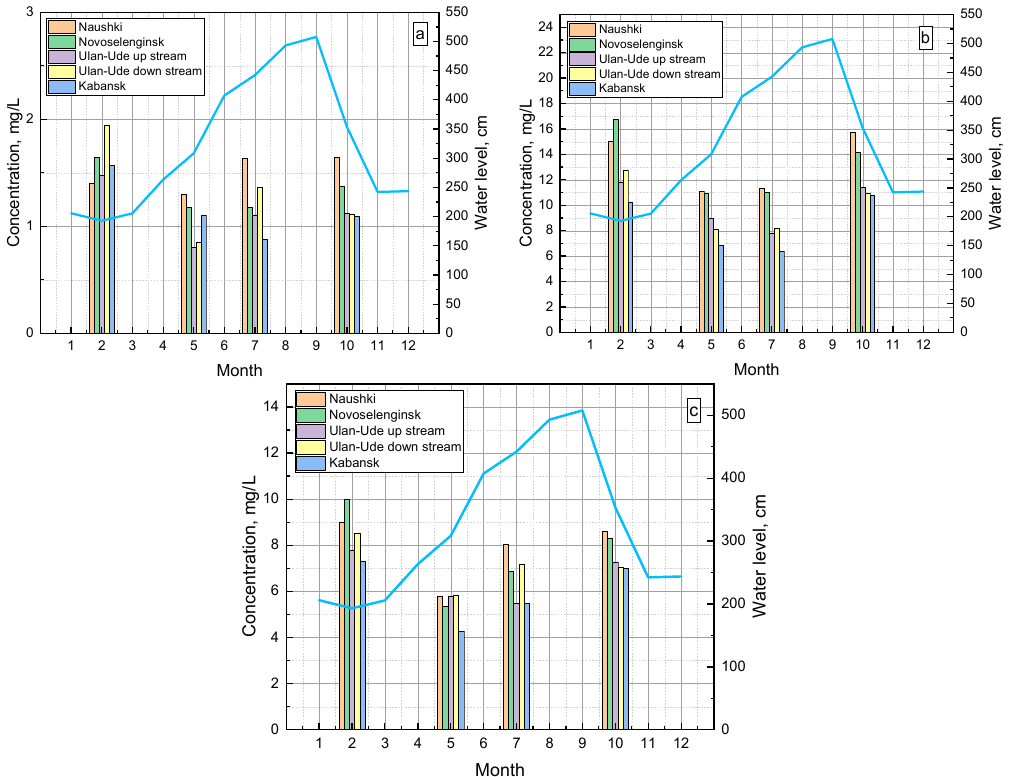
Figure 11. Seasonal changes in the content of major ions in the Selenga water (( а )—Cl − , ( b )—SO 42 − , ( c )—Na + ).